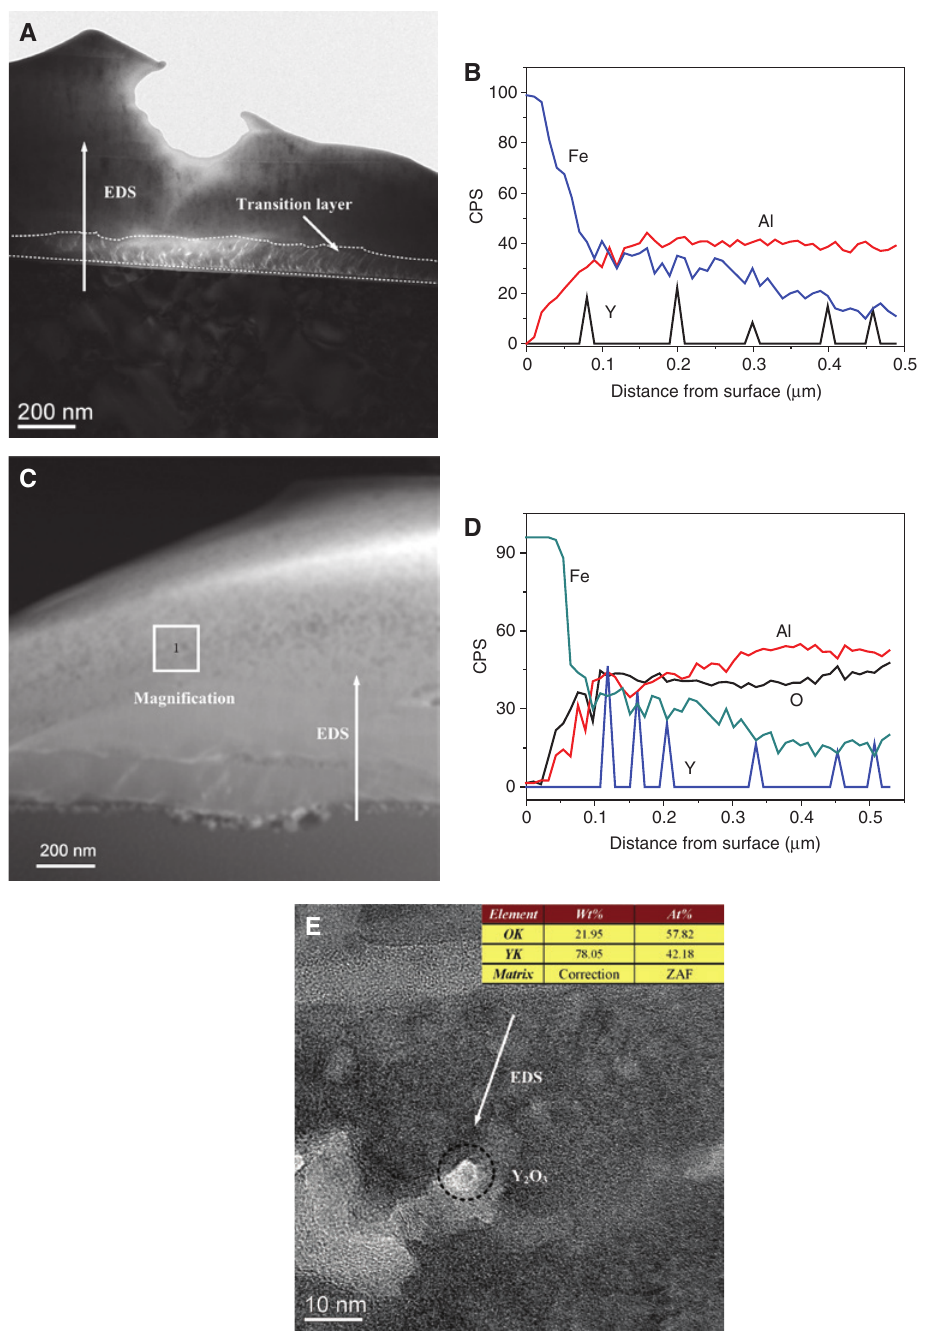
Figure 3: TEM analysis and EDX spectrogram for the coating before and after oxidization: (A) coating before oxidization, (B) EDX analysis for the coating before oxidization, (C) coating after oxidization, (D) EDX analysis for the coating after oxidization, and (E) image for STEM magni- fied in Zone 1 in panel between the matrix and the coating. The crystalline grains Figure 3A, there was a transition layer at the junction grew in a columnar manner because of a low sputtering between the coating and the matrix. At the initial stage temperature. As seen in Figure 3B and D, element Y really of sputtering, during the process of double glow plasma existed in the coating before and after oxidization. Mean- diffusion, metalizing, sputtering, heavy ion sputtering, while, the distribution of element Y was not continuous. and sedimentation occurred simultaneously at a low tem- On the basis of the amplification of the local region in perature, thus producing a transition layer at the junction